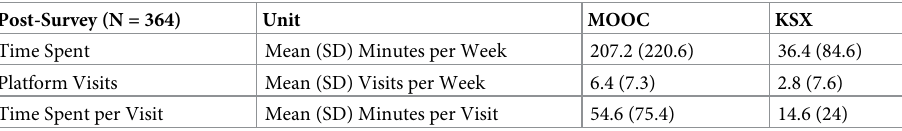
Table 2. Platform utilization of MOOC \ KSX